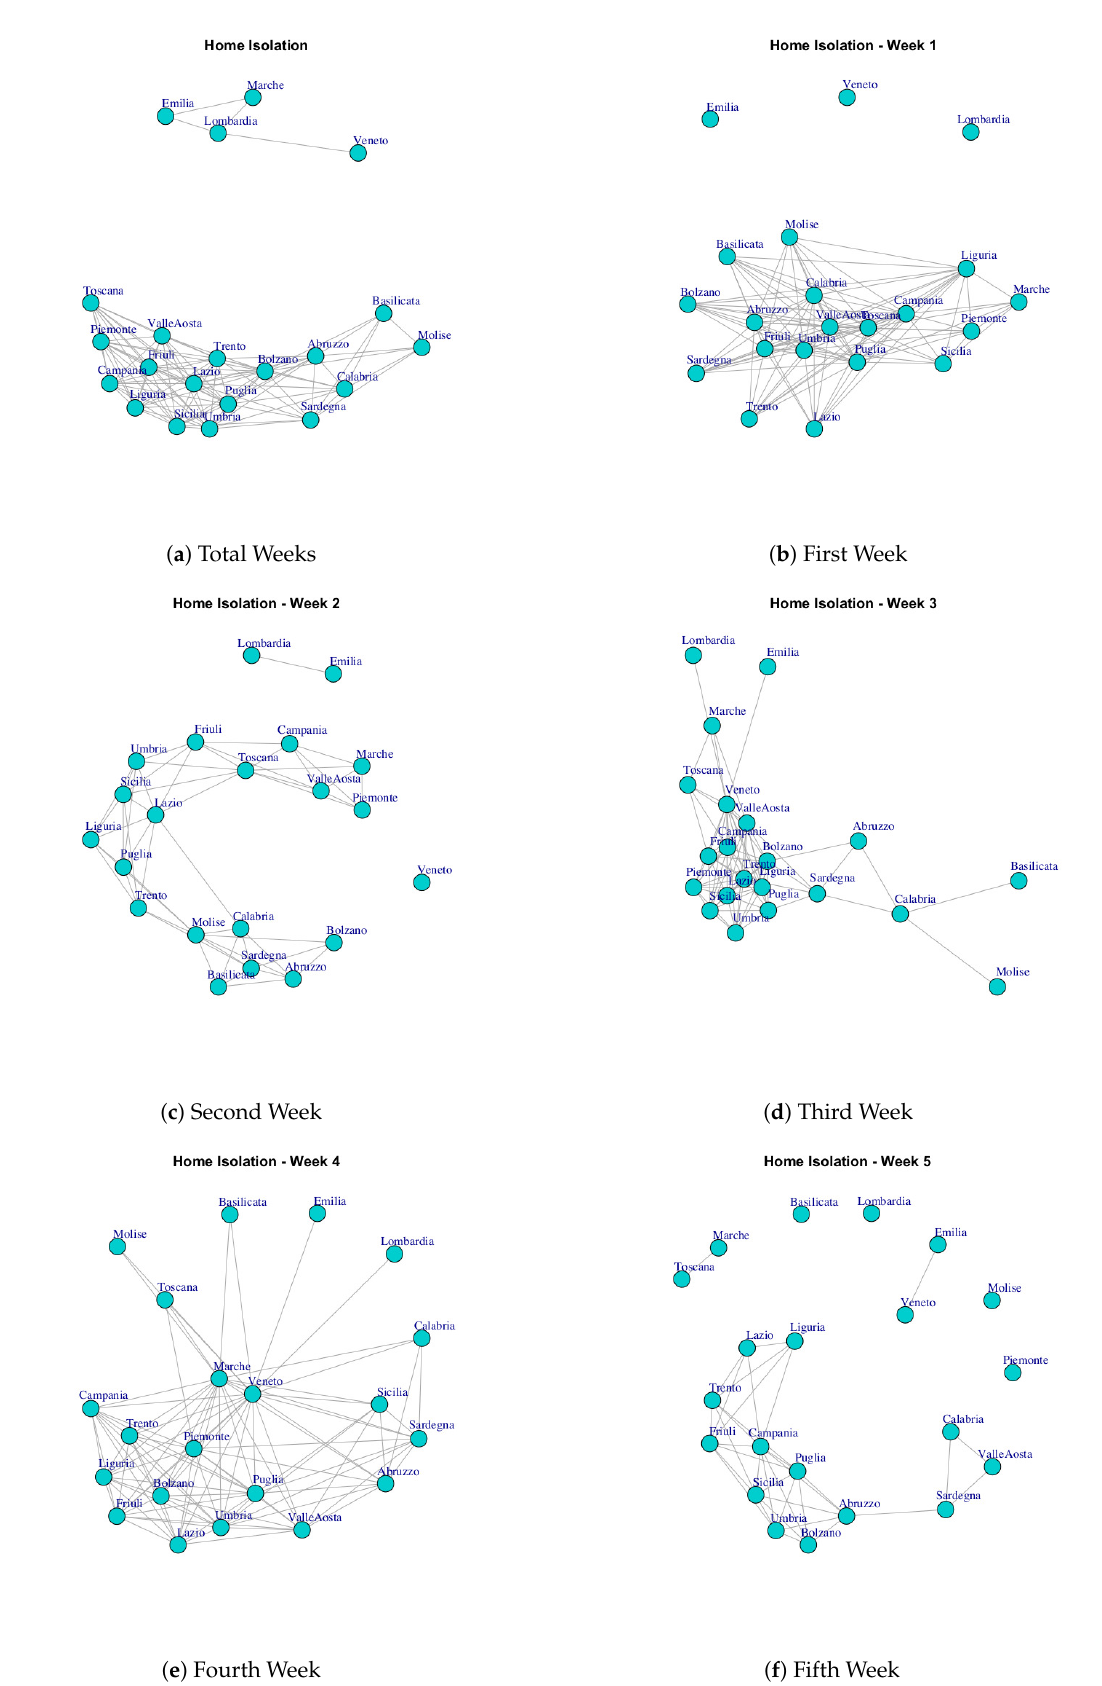
Figure 6. Evolution of Home Isolation